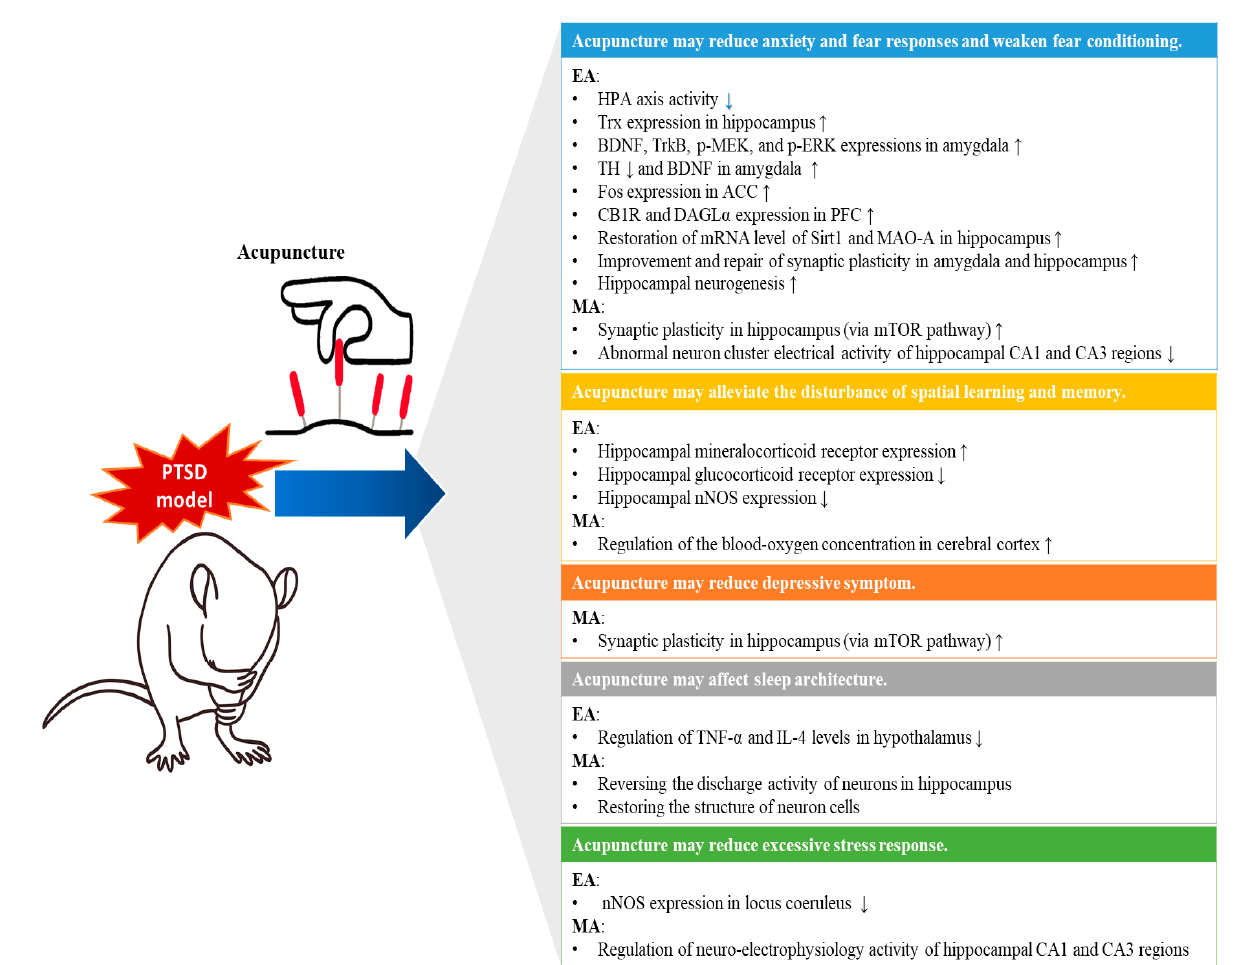
Figure 3. Possible underlying mechanisms of acupuncture for PTSD. ACC, anterior cingulate cortex; BDNF, brain-derived neurotrophic factor; CB1R, cannabinoid type 1 receptor; DAGL α , diacylglycerol lipase α ; EEG, electroencephalogram; HPA axis, hypothalamic-pituitary-adrenal axis; IL, interleukin; MAO-A, monoamine oxidase A; mRNA, messenger ribonucleic acid; mTOR, mammalian target of rapamycin; nNOS, neuronal nitric oxide synthase; p-ERK, phosphorylated extracellular signal-regulated kinase; p-MEK, phosphorylated mitogen-activated protein/extracellular signal-regulated kinase kinase; PFC, prefrontal cortex; Sirt1, Sirtuin 1; TH, tyrosine hydroxylase; TNF, tumor necrosis factor; TrkB, tropomyosin-related kinase B; Trx,